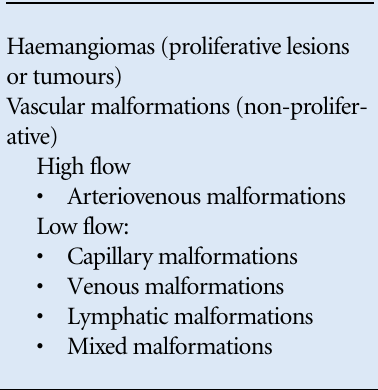
Table II.Classification of